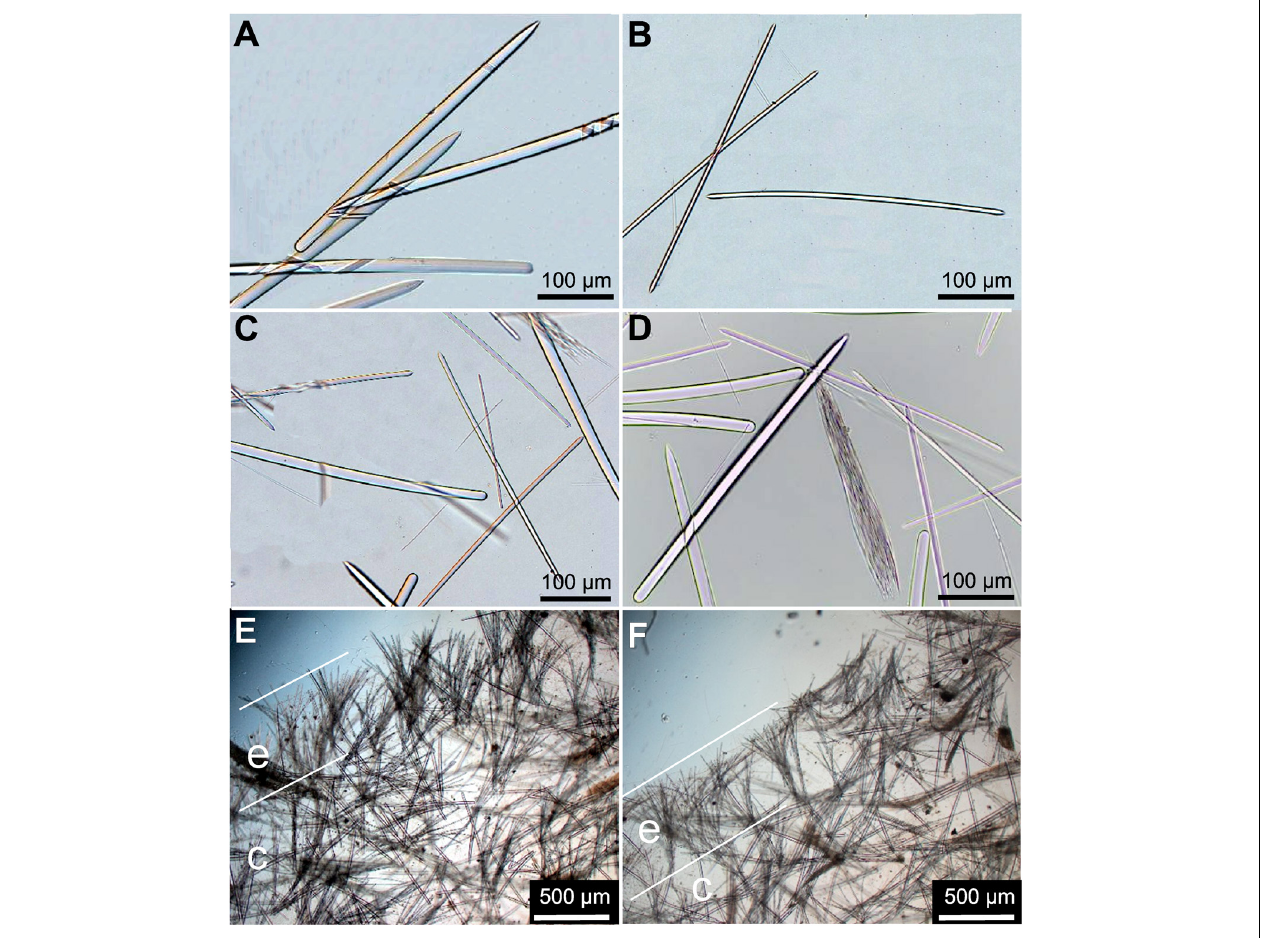
FIGURE 4 | Spicules of Tedania ( Tedaniopsis ) rappi sp. nov. (Paratype) as seen with a light microscope. (A) Styles. (B) Tornotes. (C) Different kinds of spicules. (D) Group of onychaetes in tricodragmata formation. (E,F) Skeleton with marked differentiation between ectosome (e) and choanosome